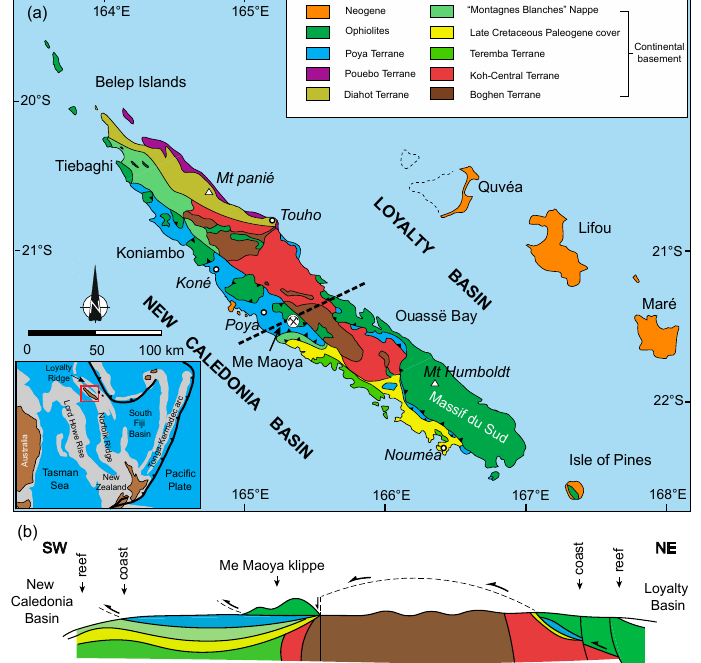
Figure 1. ( a ) Sketch geological map of New Caledonia, modified from Reference [ 25 ] ; ( b ) cross section of New Caledonia, modified from Reference [ 26 ] .